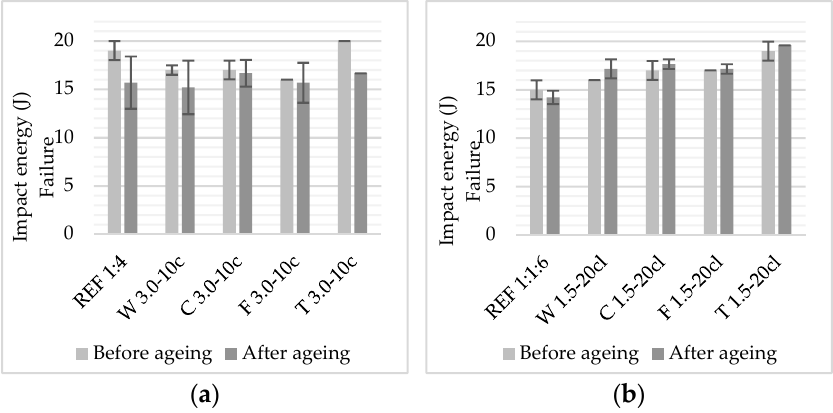
Figure 5. Impact energy before and after ageing at failure of the mortars: ( a ) cement mortars and ( b ) cement-lime mortars.